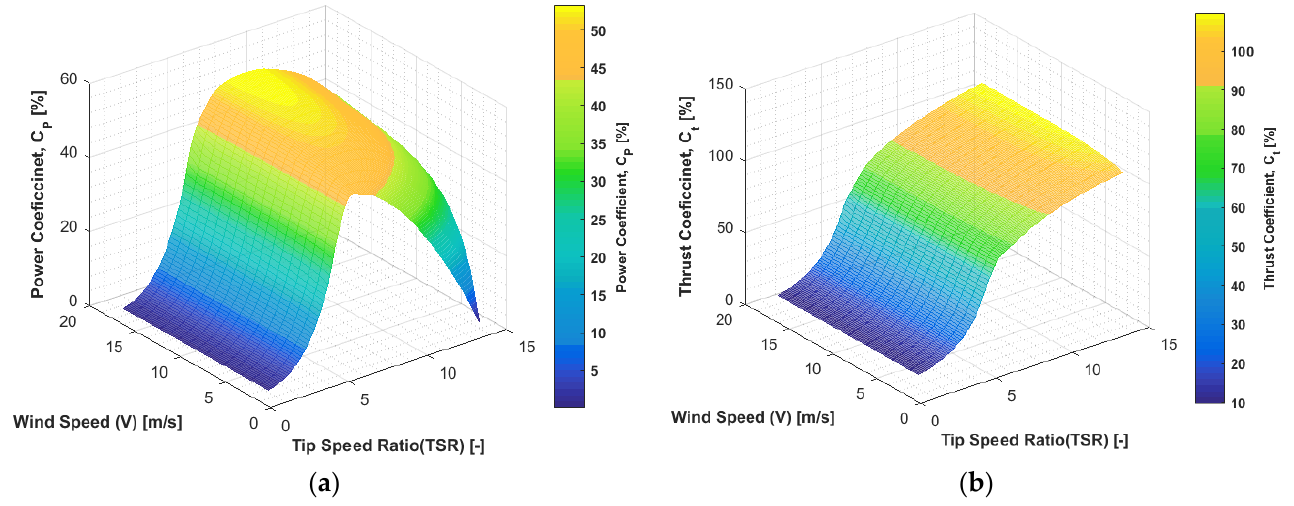
Figure 12. Performance coefficients for different design parameters. ( a ) Power coefficient vs. TSR and wind speed, ( b ) Thrust coefficient vs. TSR and wind speed.